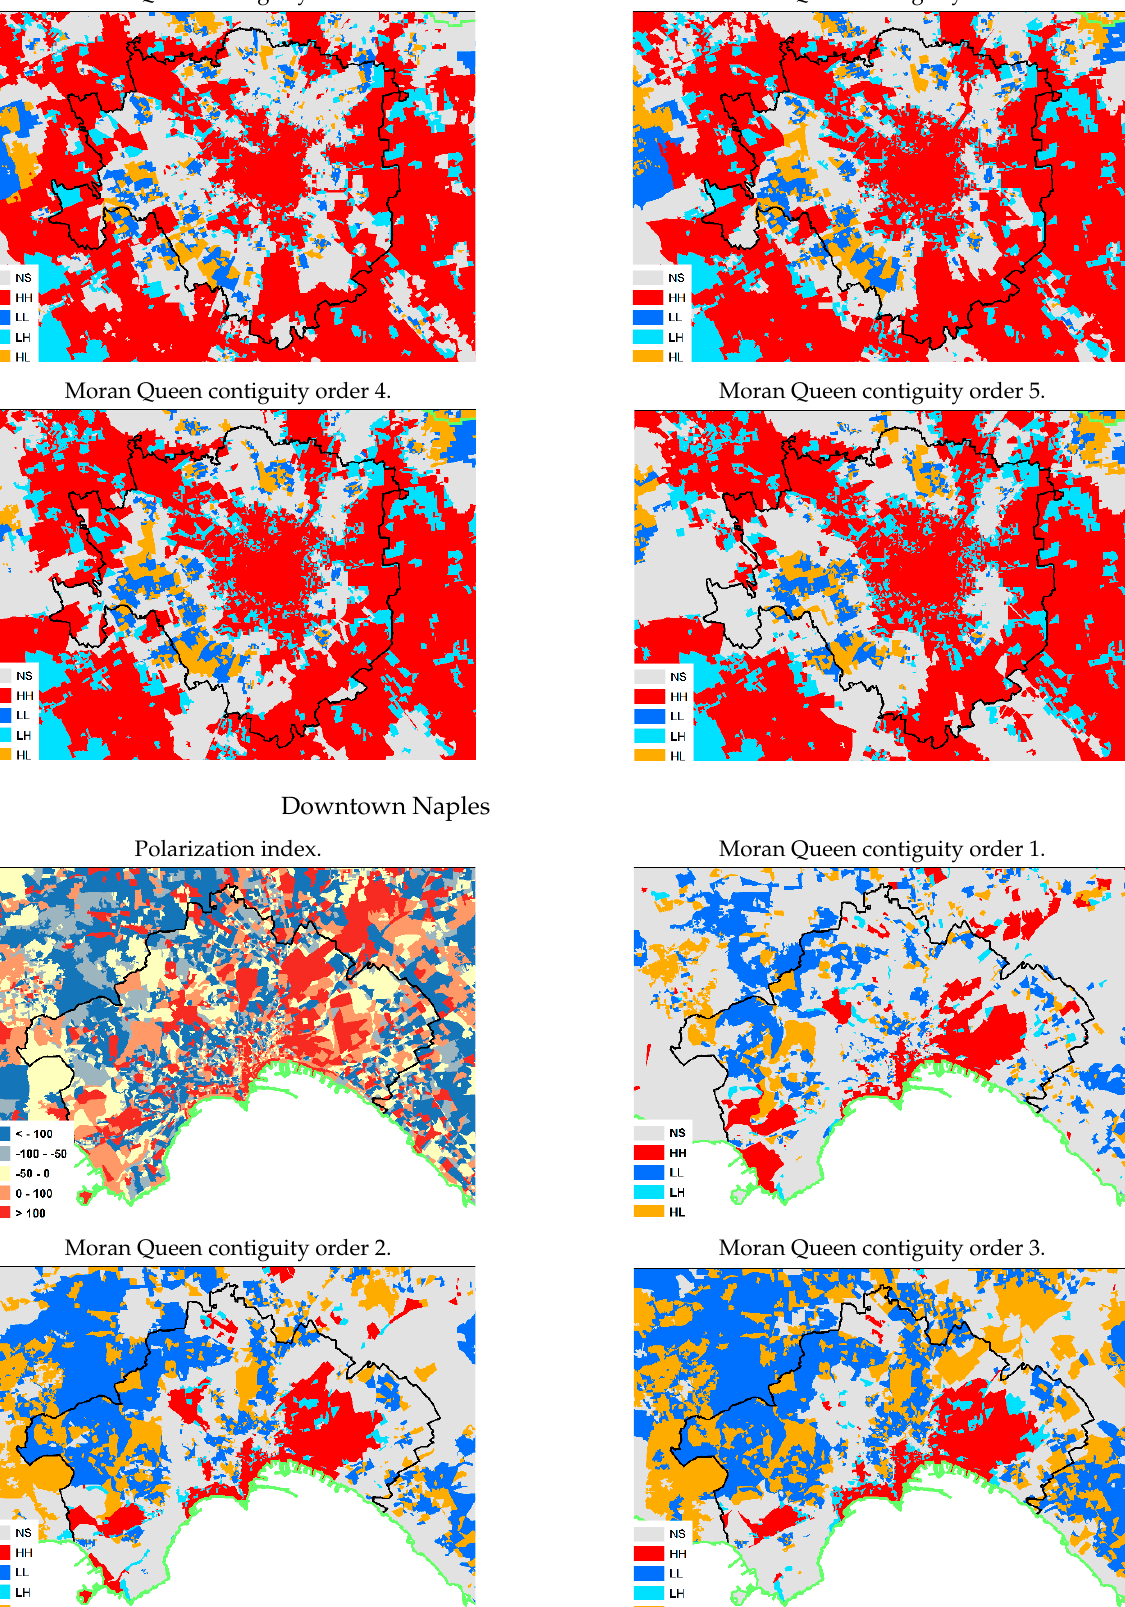
Moran Queen contiguity order 3.